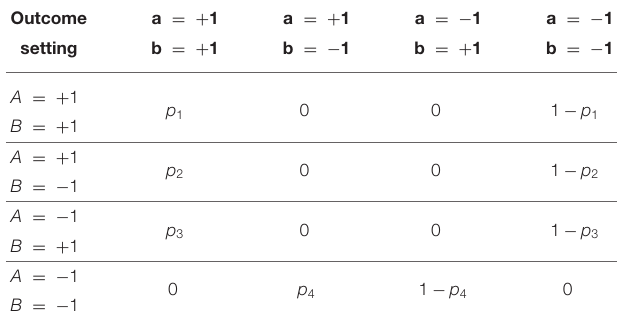
TABLE 1 | Conditional probabilities for a toy model with two binary inputs and two binary outcomes that cannot be reproduced by a realistic and local underlying theory [21]. Outcome setting